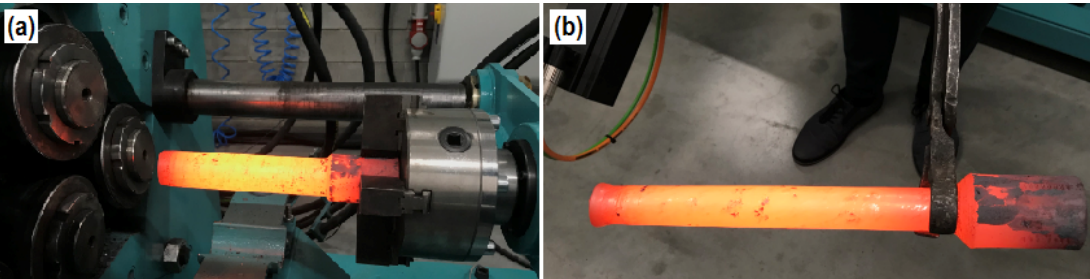
Figure 6. Obtained in experimental verification hollow parts: ( a ) with diameter reduced to Ø40 mm placed in gripper and showing skew rolling mill workspace; ( b ) part with diameter reduced to Ø30 mm.